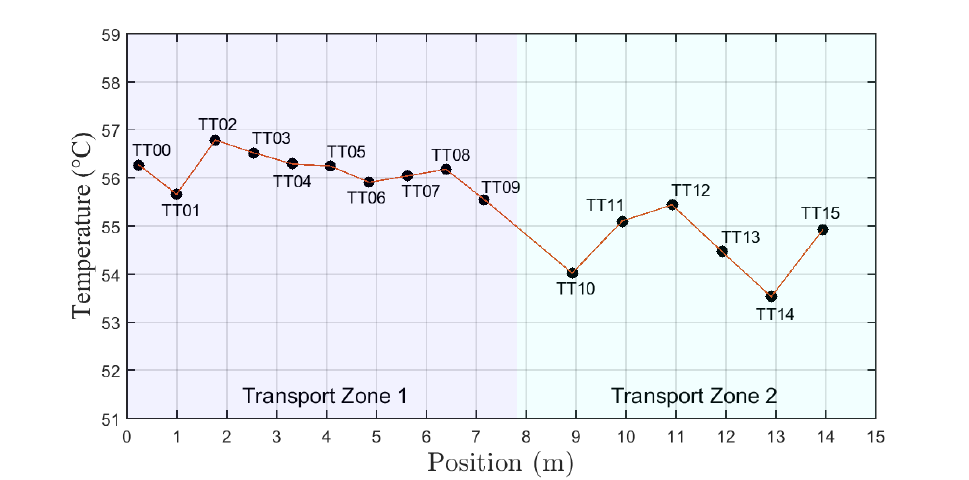
Figure 10. Graph of temperature with position (temperature profile) for test type A.